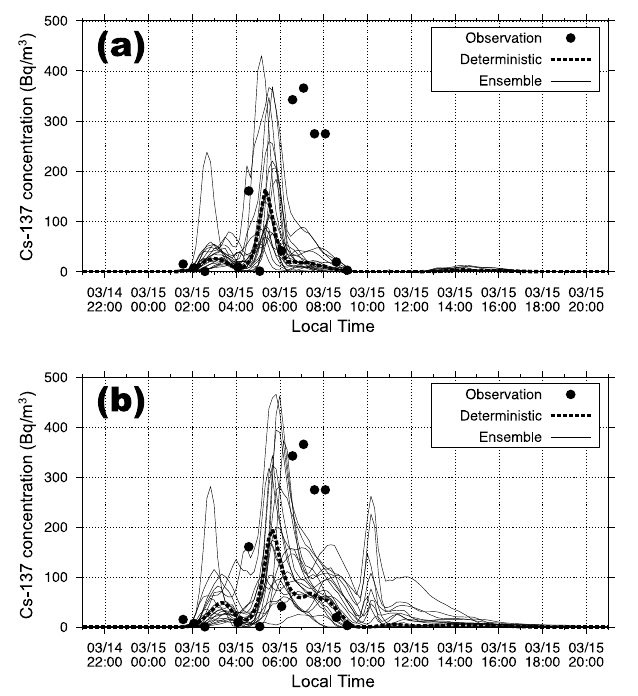
Figure 3. ( a ) Ensemble analysis members and a deterministic analysis member of Cs-137 concentration at the model surface layer (below 40 m) of the grid corresponding to Tokai from 21:00 14 March to 21:00 15 March local time. ( b ) Same as ( a ) except for forecast members, which were initiated at 21:00 14 March local time. Circles indicate the measurements at Tokai.